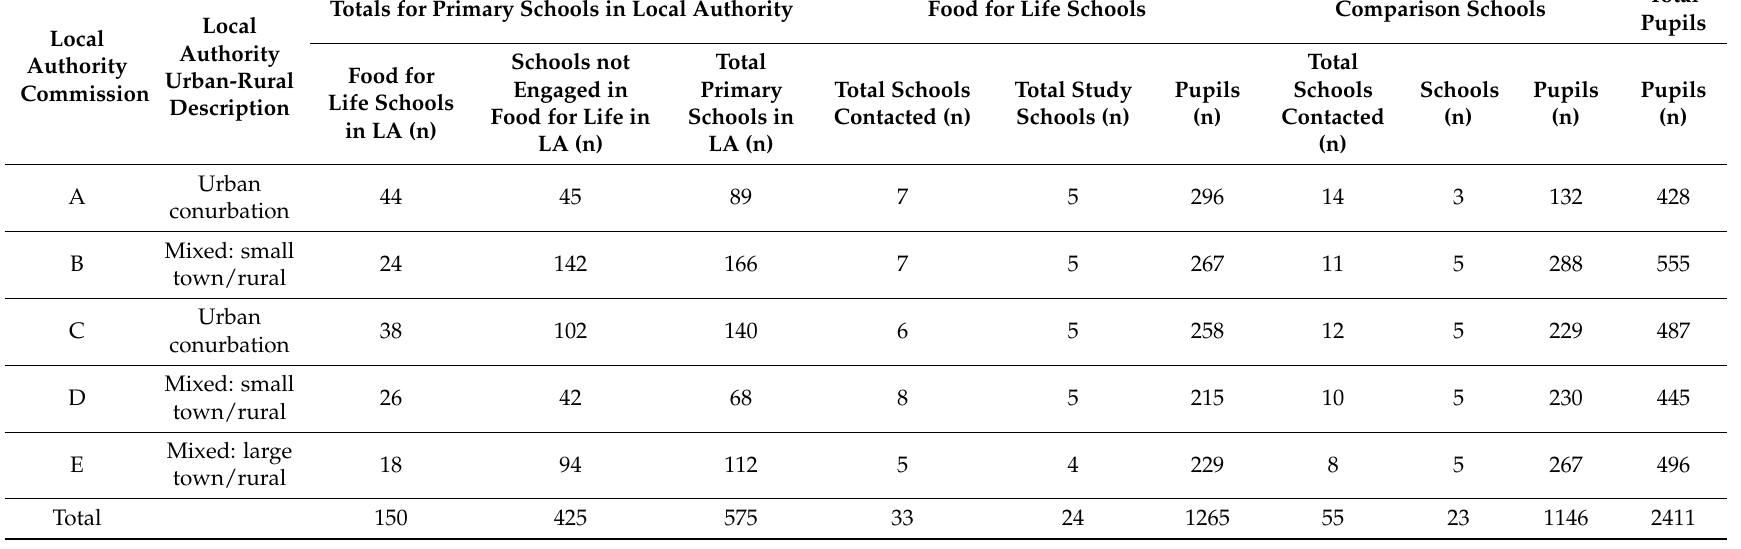
Table 1. Characteristics of the study population by local authority area